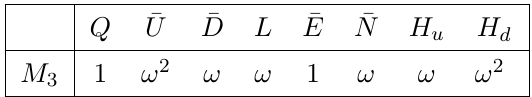
Table 1 . The representation of charged particle under matter